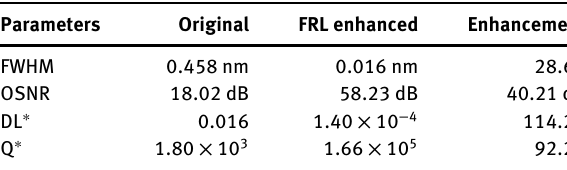
Table 2: A feature comparison between the original and the FRL enhanced microtubule